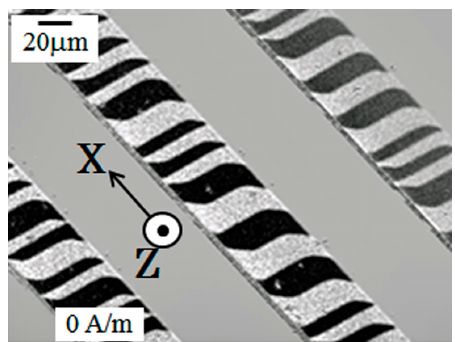
Figure 3. Magnetic domain of the sensor element observed by Kerr microscope.